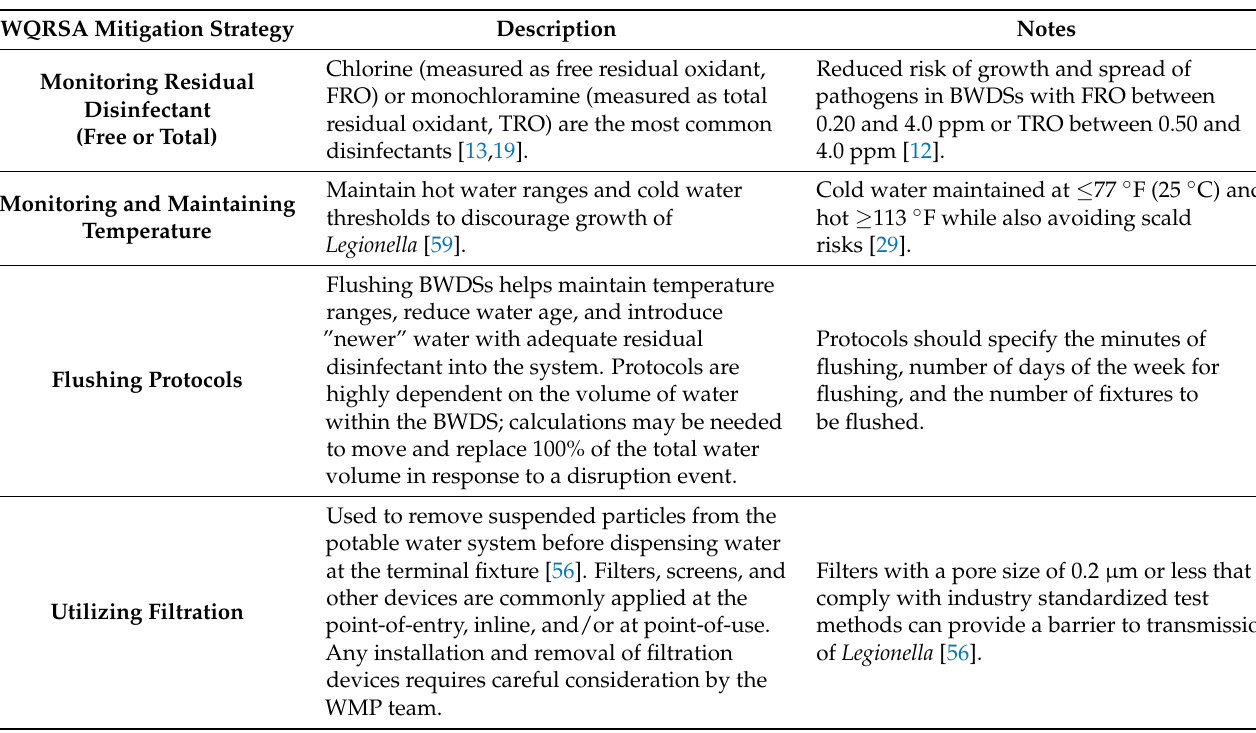
Table 1. WQRSA Mitigation